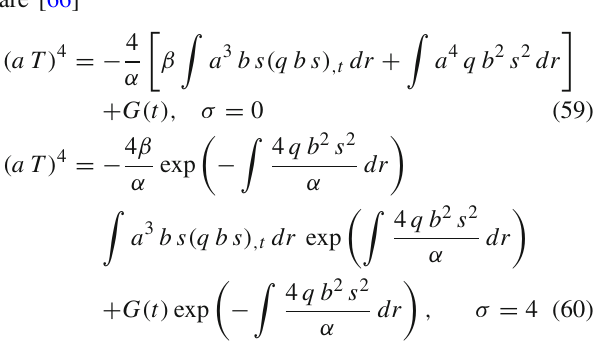
(cid:2) (cid:3) exp ( − γ R ) − 1 with λ = 0 . 1 & γ = 0 . 0002